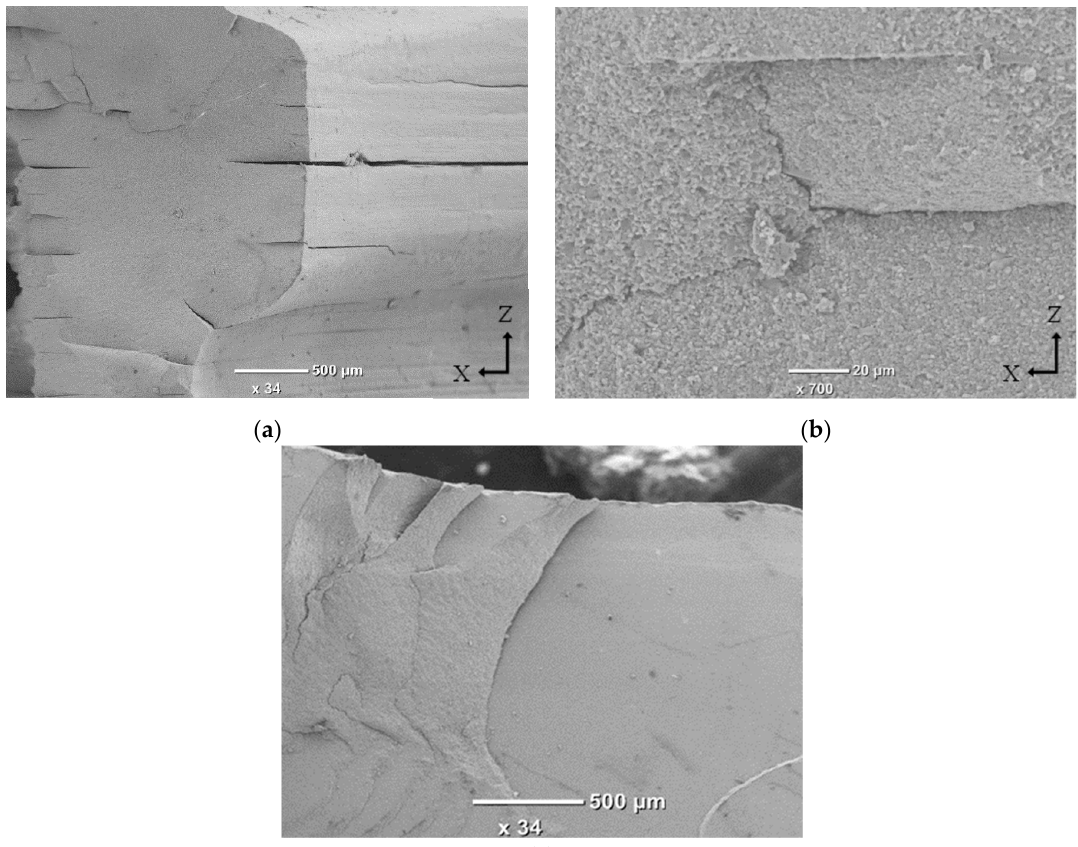
Figure 11. SEM images of a fracture surface at ( a ) low magnification and ( b ) high magnification. The legend axis indicates build direction was in the vertical (Z) direction. ( c ) Top side of the fracture surface.